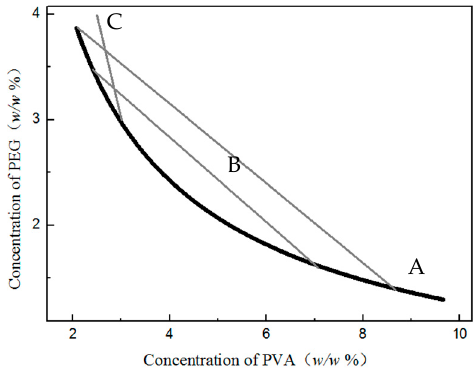
Figure 3. Phase diagram of the polyethylene glycol/polyvinyl alcohol (PEG/PVA) ATPS in 85 °C (A: binodal line; B: tie-lines; C: the concentration ratio chosen in the research).